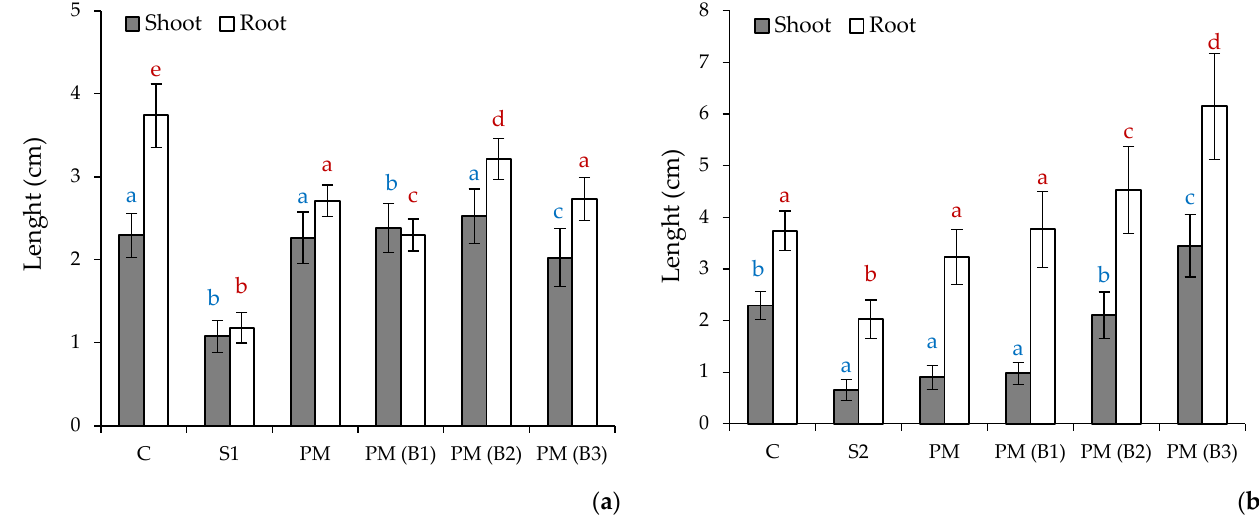
Figure 3. Data represent the average value ± the standard deviation ( n = 15) of the length of roots and shoots of the Sinapis alba L. seeds tested on soil S1 ( a ) and S2 ( b ). Different letters indicate no significant differences Tukey’s test HSD ( p > 0.05); C—reference soil.